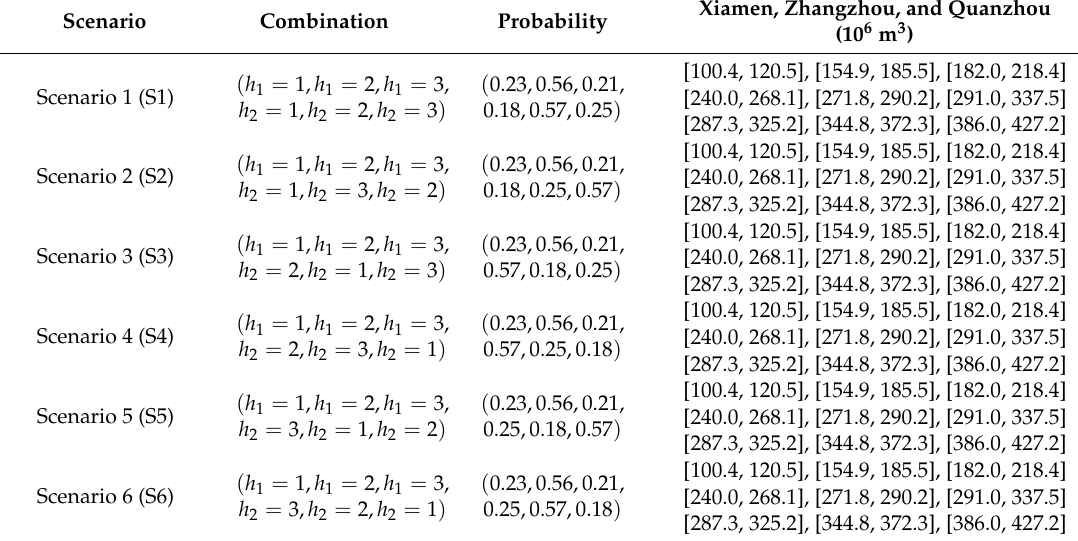
Table 2. Stochastic surface